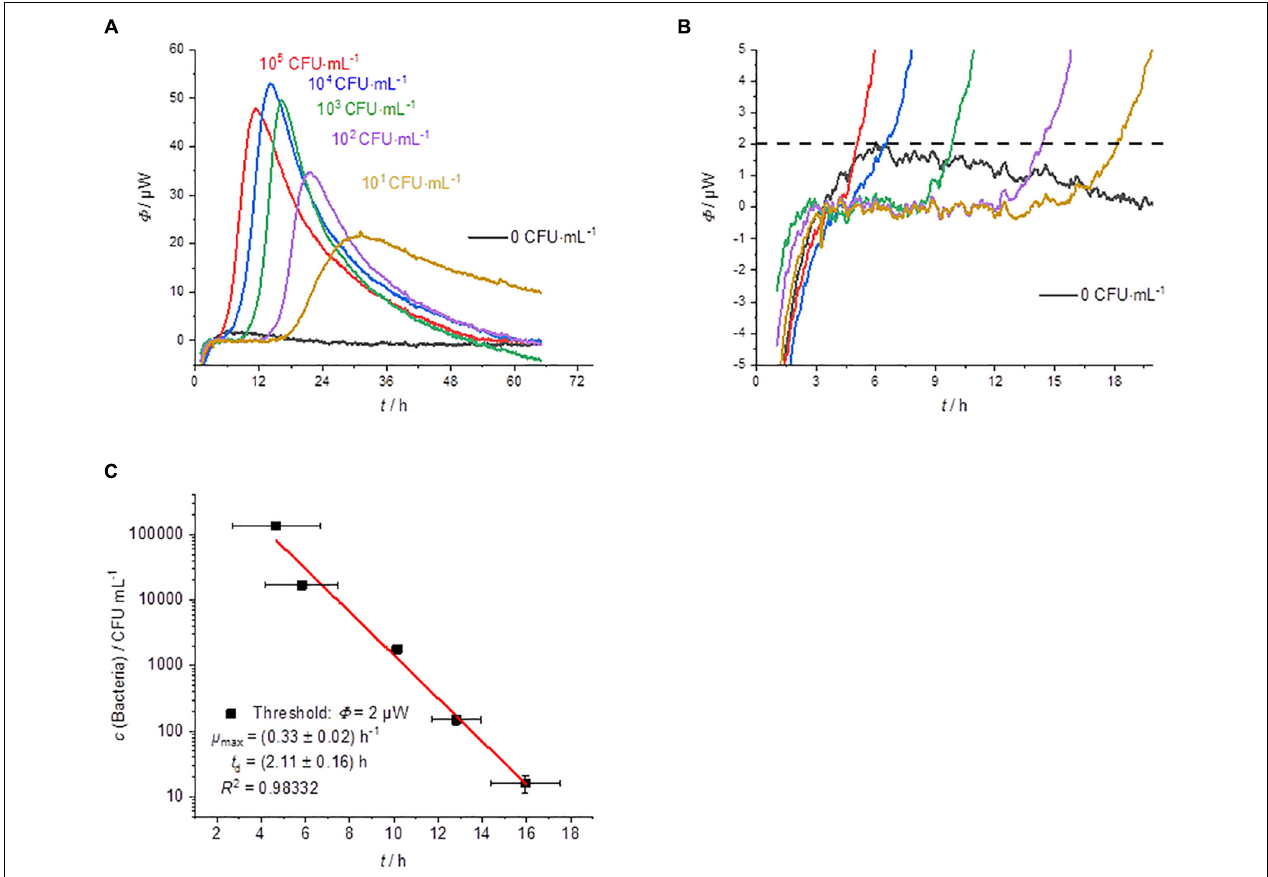
FIGURE 4 | Summary of the results of the cultivation of membrane filters onto MRS-agar performed by IMC experiments (GF). (A) Dependency of the heat traces on the initial bacterial concentration. (B) Detail magnification of the heat signal near the quantification limit, the dotted line represents the postulated threshold value (cid:56) dect . = 2 µ W. (C) Dependency of the detection time on the initial bacterial